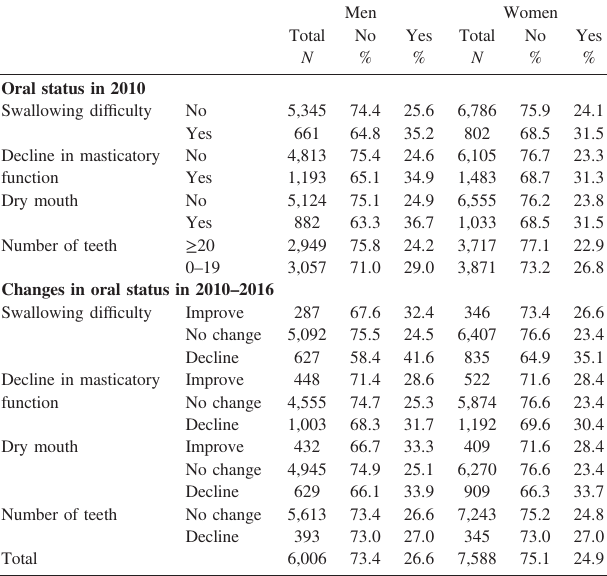
Table 3. Probability of the onset of subjective cognitive com-